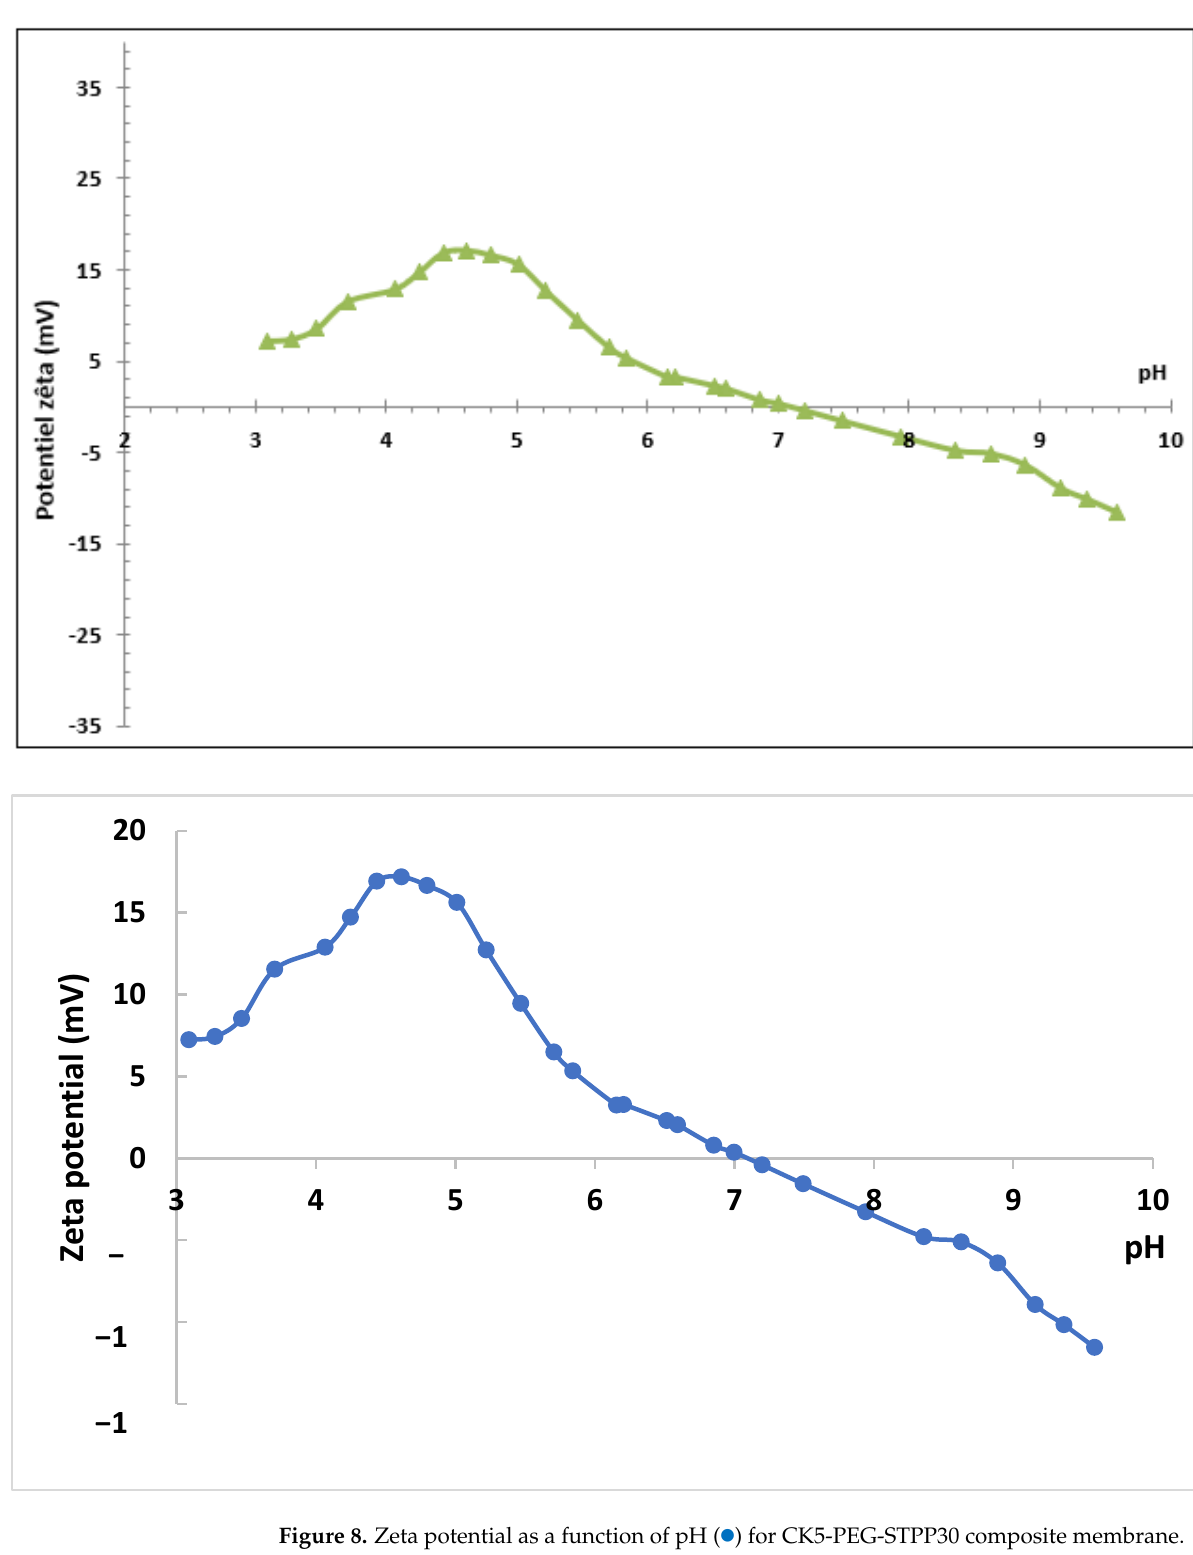
Figure 8. Zeta potential as a function of pH ( ) for CK5-PEG-STPP30 composite membrane.